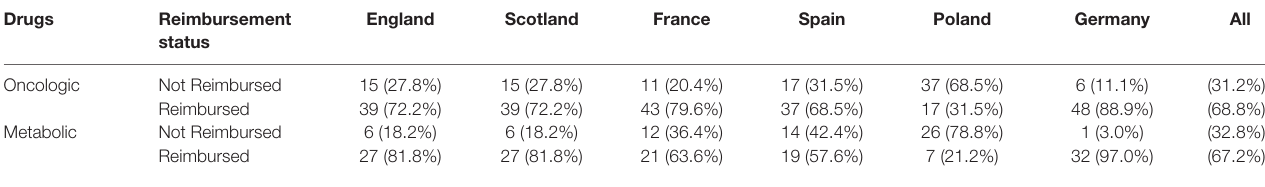
TABLE 2 | Reimbursement status for oncologic and metabolic